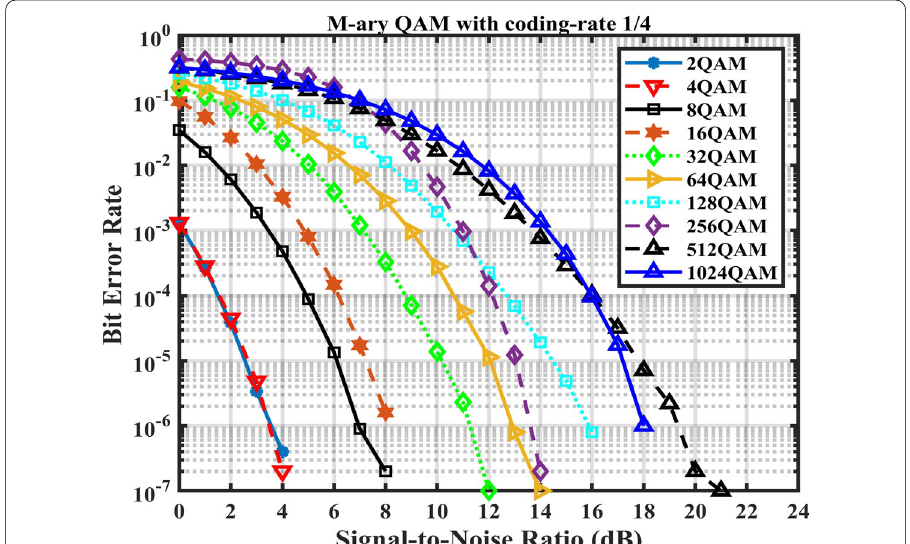
Fig. 10 BER versus SNR for different M-ary QAM with 1/4 code rate. This graph depicts the performance of different M-ary QAM with 1/4 code rate combination. The performance is described in terms of BER versus